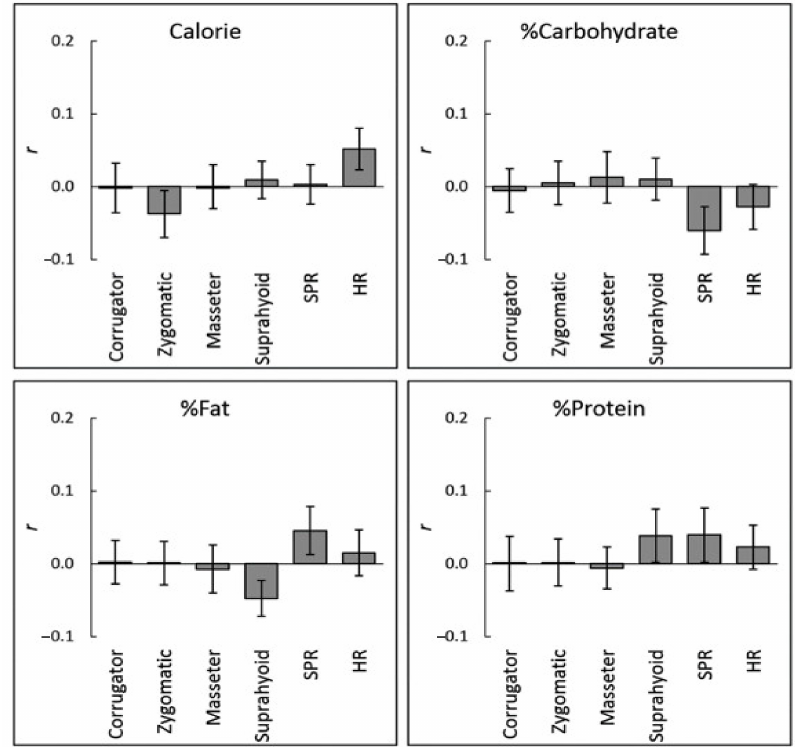
Figure 4. Mean (with standard error) intra-individual correlation coefficients ( r ) between objective nutritional values and physiological activity while viewing food images. No significant correlation was observed ( p > 0.10). Corrugator = corrugator supercilii; Zygomatic = zygomatic major; SPR = skin potential response; HR = heart